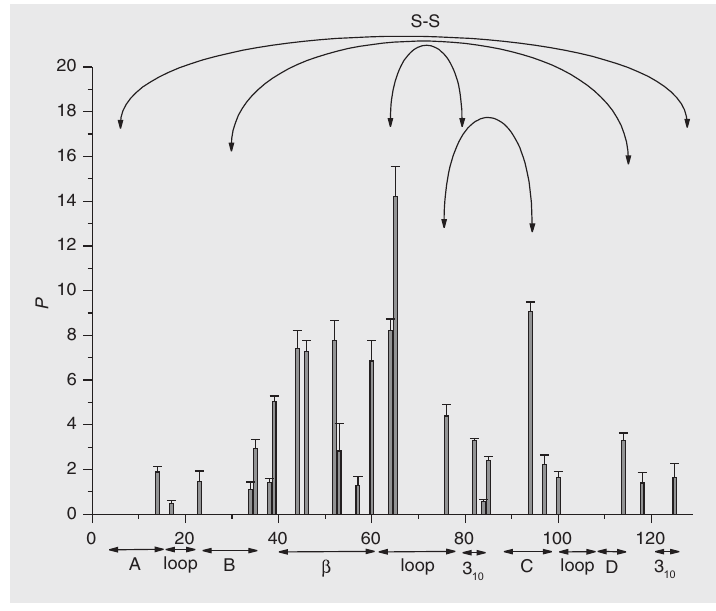
Figure 2. Protection factors, P , for the heat-induced transient state of hen egg white lysozyme as a function of residue number. Secondary structure elements are indi- cated at the bottom: “A-D” denote the four α -helices, “ß” the ß-sheet and “loop” the loop-regions. “3 10 ” denotes the 3 10 -helices and “S-S” cross-linked cysteine residues. The transient state exhibits residual secondary structure with highest P -factors found at the cross-linked cysteines C64 and C94 as well as in the three-stranded